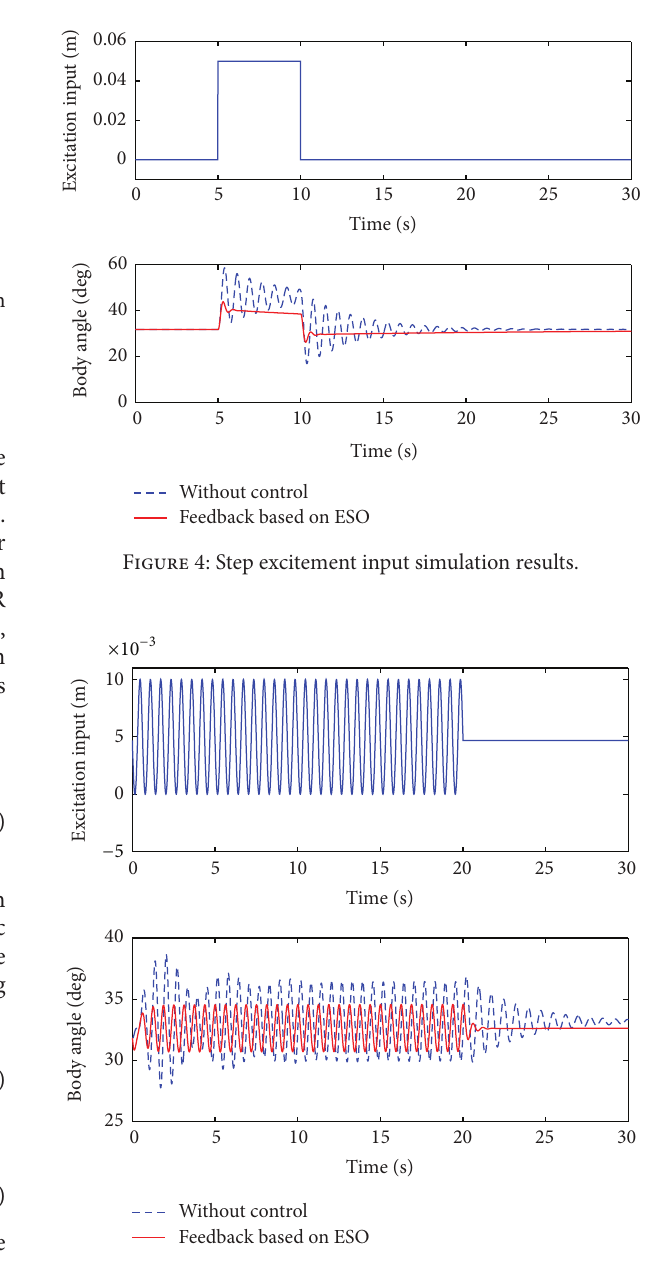
Figure 5: Continuous sinusoidal excitement input simulation